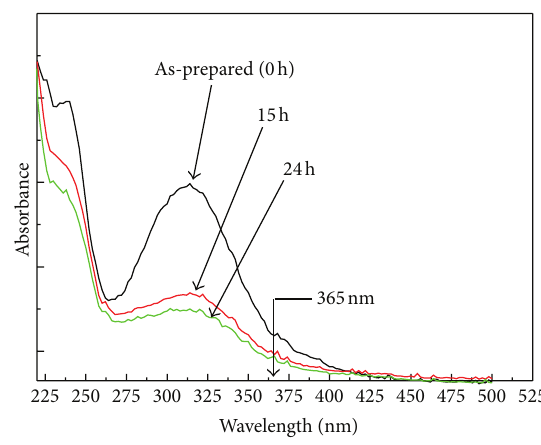
Figure 5: UV-visible spectra for as-prepared SinA monolayer and irradiated by UV radiation (365nm) for 15 and 24